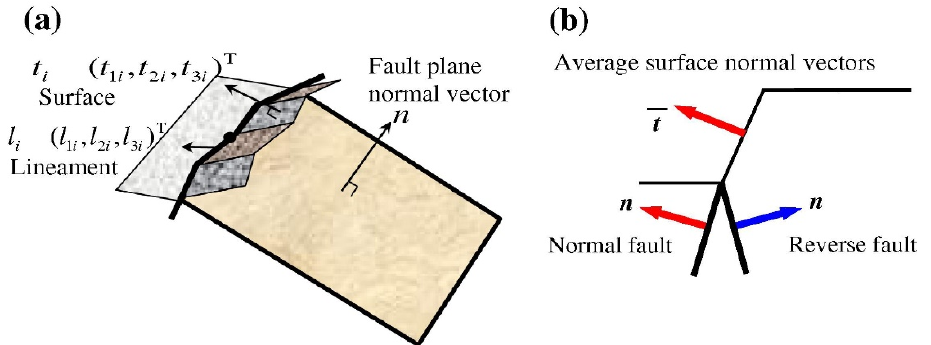
Figure A1. A schematic diagram of azimuth values, normal vectors, and fracture planes. ( a ) The azimuth of fracture plane; ( b ) The average surface normal vectors of fracture plane [57].